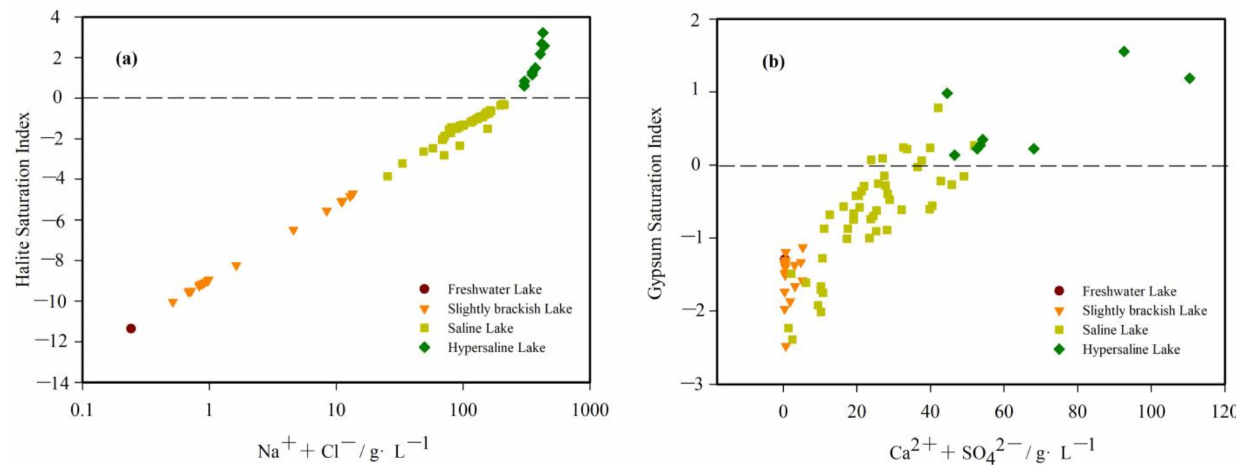
Figure 6. The relationships between ( a ) Halite Saturation Index and Na + + Cl − /g L − 1 and ( b ) Gypsum Saturation Index and Ca 2+ + SO 42 − /g L − 1